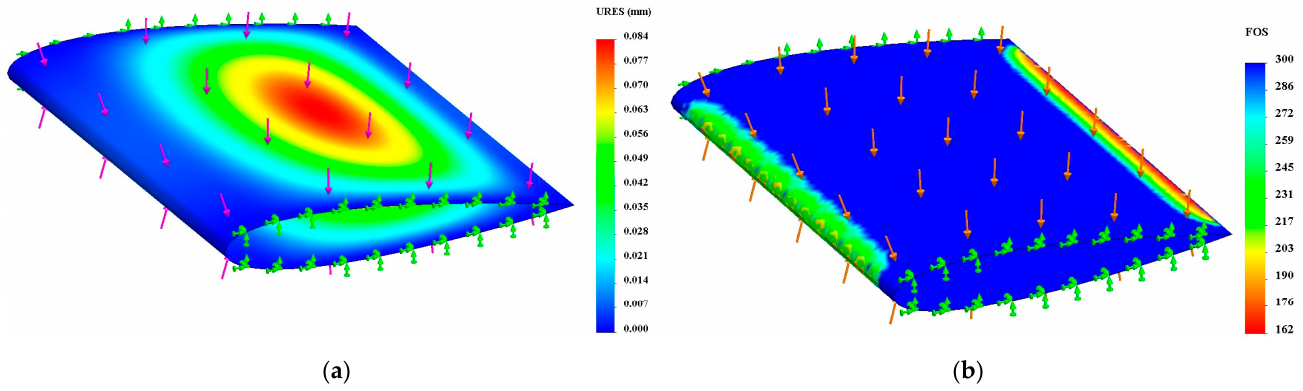
Figure 15. Wing skin plots ( a ) resultant displacement; ( b ) Minimum factor of safety across all plies